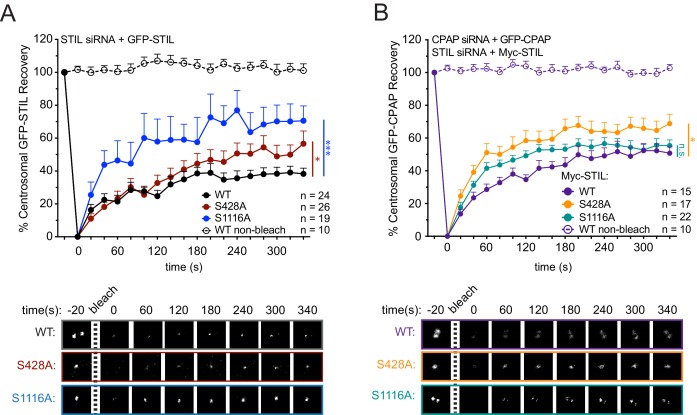
STIL S428 phosphorylation promotes the stable integration of CPAP into the centrosome.(A) Cells were depleted of endogenous STIL and replaced with the indicated transgene. Myc-GFP-STIL centrosomal foci were photobleached, and fluorescence recovery was measured. The number of quantified photobleaching and recovery events are indicated. Representative timepoints are shown below. Error bars represent the standard error of the mean. (B) Cells were depleted of endogenous STIL and CPAP and replaced with the indicated Myc-STIL-T2A-GFP-CPAP transgene. GFP-CPAP centrosomal foci were photobleached, and fluorescence recovery was measured. The number of quantified photobleaching events is indicated. Representative timepoints are shown below. Error bars represent the standard error of the mean. Asterisks indicate statistically significant differences between measurements (*: p<0.05; **: p<0.005; ***: p<0.0005). Statistics were calculated using an unpaired t-test against the population of recovery measurements between indicated samples at the 340 s timepoint.
10.7554/eLife.46054.017Figure 4—source data 1.Figure 4 Data and Statistical Analysis.

10.7554/eLife.46054.018Figure 4—source data 2.Figure 4—figure supplement 1 Data and Statistical Analysis.

10.7554/eLife.46054.019Figure 4—source data 3.Figure 4—figure supplement 2 Data and Statistical Analysis.